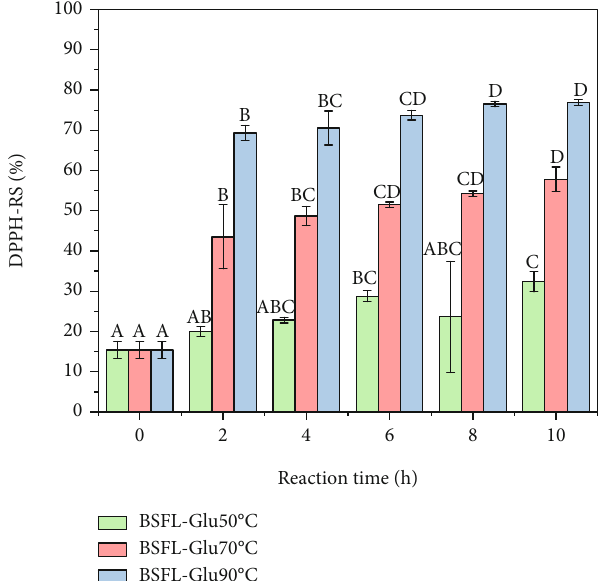
Figure 3: DPPH radical scavenging activity of BSFL-Glu conjugates as a function of reaction temperature. Values are mean ± standard deviation ; means with di ff erent superscripts are signi fi cantly ( p < 0 : 05 ) di ff erent at the same heating temperature.